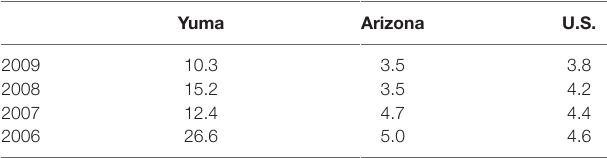
TaBle 1 | Tuberculosis incidence rates (cases per 100,000).